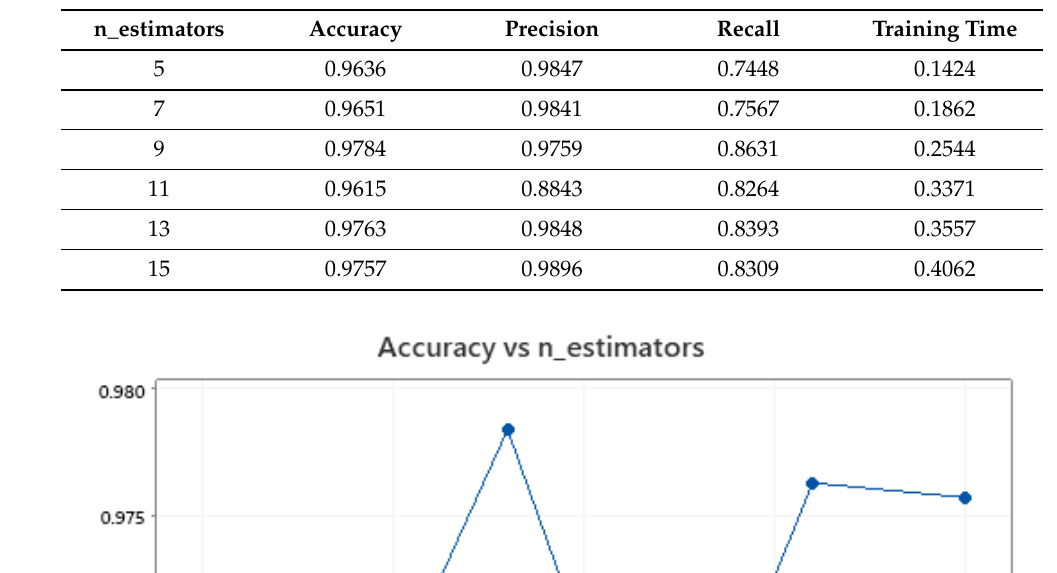
Table 5. Impact of number of estimators on accuracy, precision and recall rates for the random forest classifier.